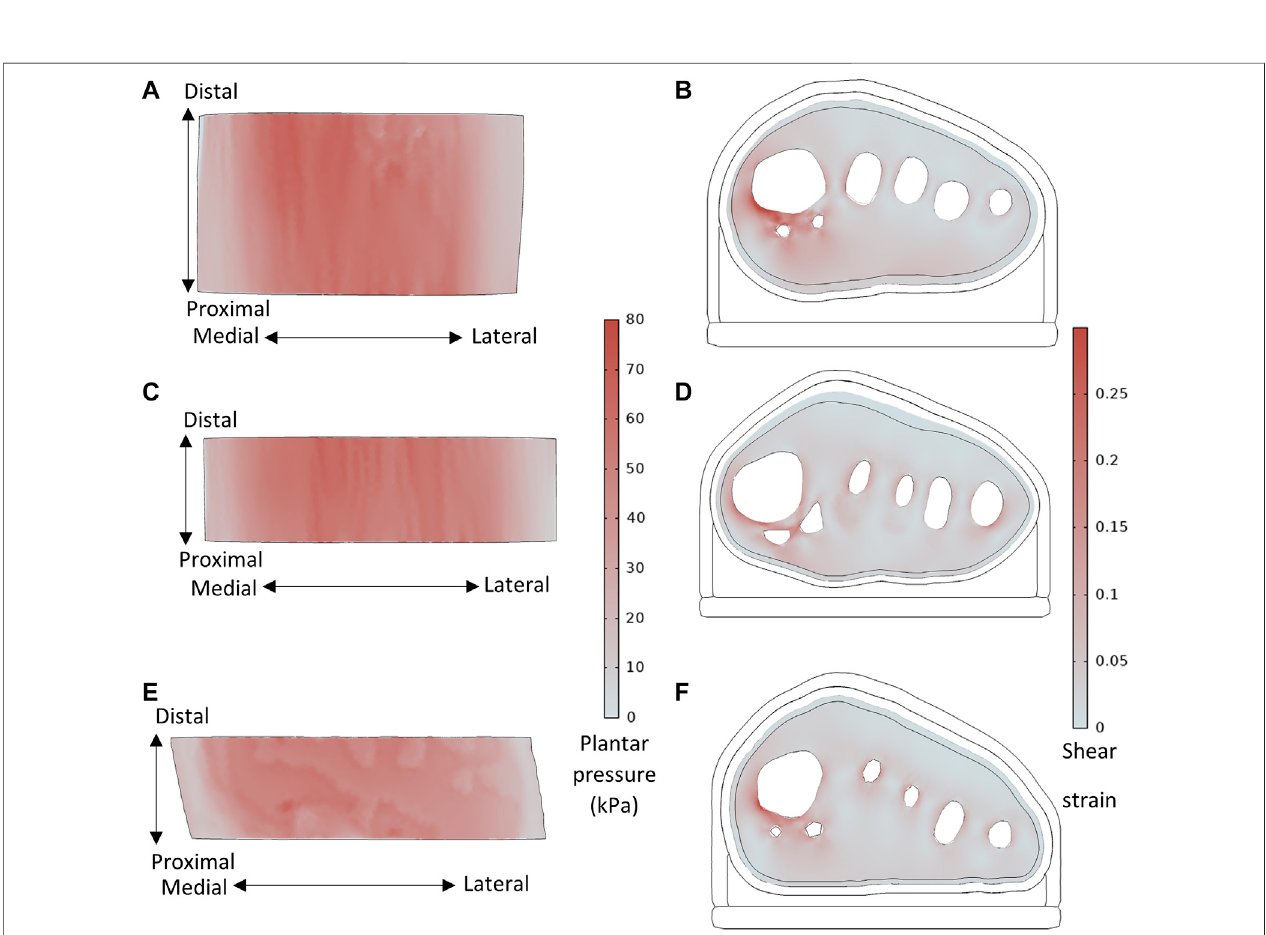
FIGURE5 | Plantar pressure and shearstrain(taken from slice through sesamoid center) distributions, for (A,B) P8with sesamoids in neutral position, BMI (cid:2) 21.7, MH1 curvature (cid:2) 0.144 mm − 1 , and (C,D) P1 with displaced sesamoids, BMI (cid:2) 26.7, MH1 curvature (cid:2) 0.112 mm − 1 , and (E,F) Healthy participant, BMI (cid:2) 22.3, MH1 curvature (cid:2) 0.079mm − 1